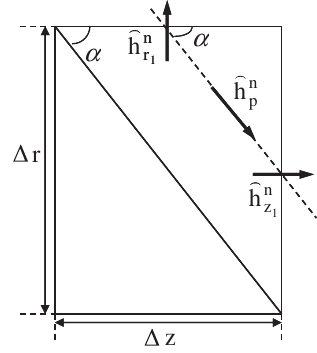
FIG. 8. The discrete magnetic field components in the grid